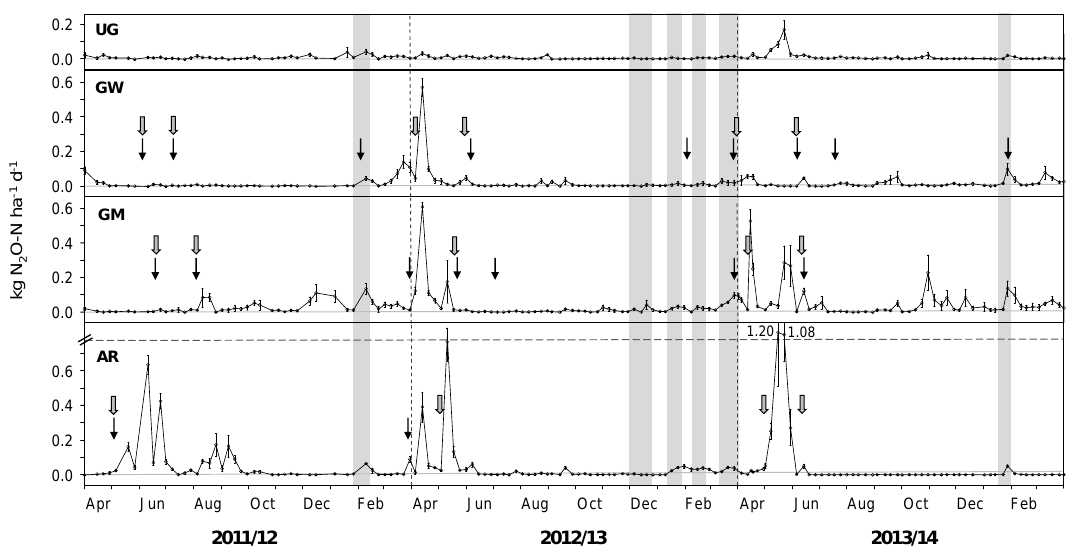
Figure 4. N 2 O exchange at the four study sites during the study period (April 2011–March 2014). Values are displayed as mean ± standard error ( n = 8). Note the broken y axis for site AR. Arrows indicate applications of slurry (black) and mineral nitrogen fertilizer (grey). Grey background represents periods with mean daily temperatures below 0 ◦ C. Table 2. Annual budgets of CO 2 exchange ( R ECO , GPP and NEE), CH 4 and N 2 O fluxes, net ecosystem carbon balance (NECB) and global warming potential (GWP) for 100 years (IPCC, 2007) for different study periods (each period is April–March). NECB is calculated from NEE and CH 4 –C as well as slurry C and harvested C. The GWP includes CO 2 –Ceq. of NEE, CH 4 –C, N 2 O–N, slurry C and harvested C. Small deviations in NEE are caused by rounding. Values are annual sums and standard errors (in